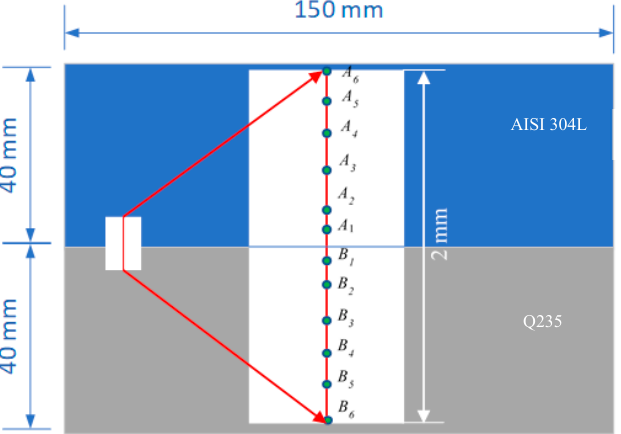
Figure 7. The sampling points used to evaluate the thermal history. Table 6. The highest temperatures and the corresponding times of the sampling points.